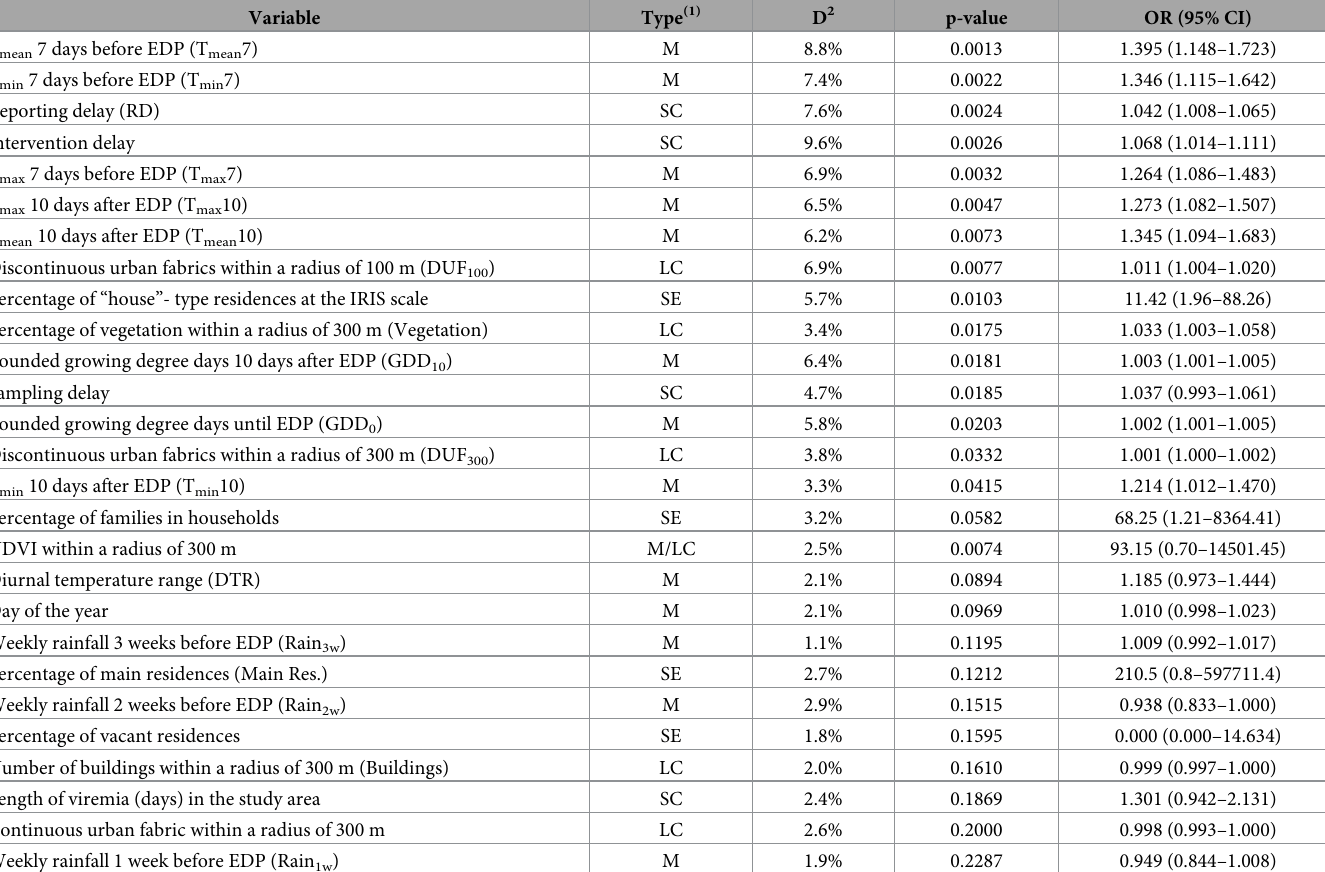
Table 4. Results of the univariate binomial regression analyses sorted according to their p-values.